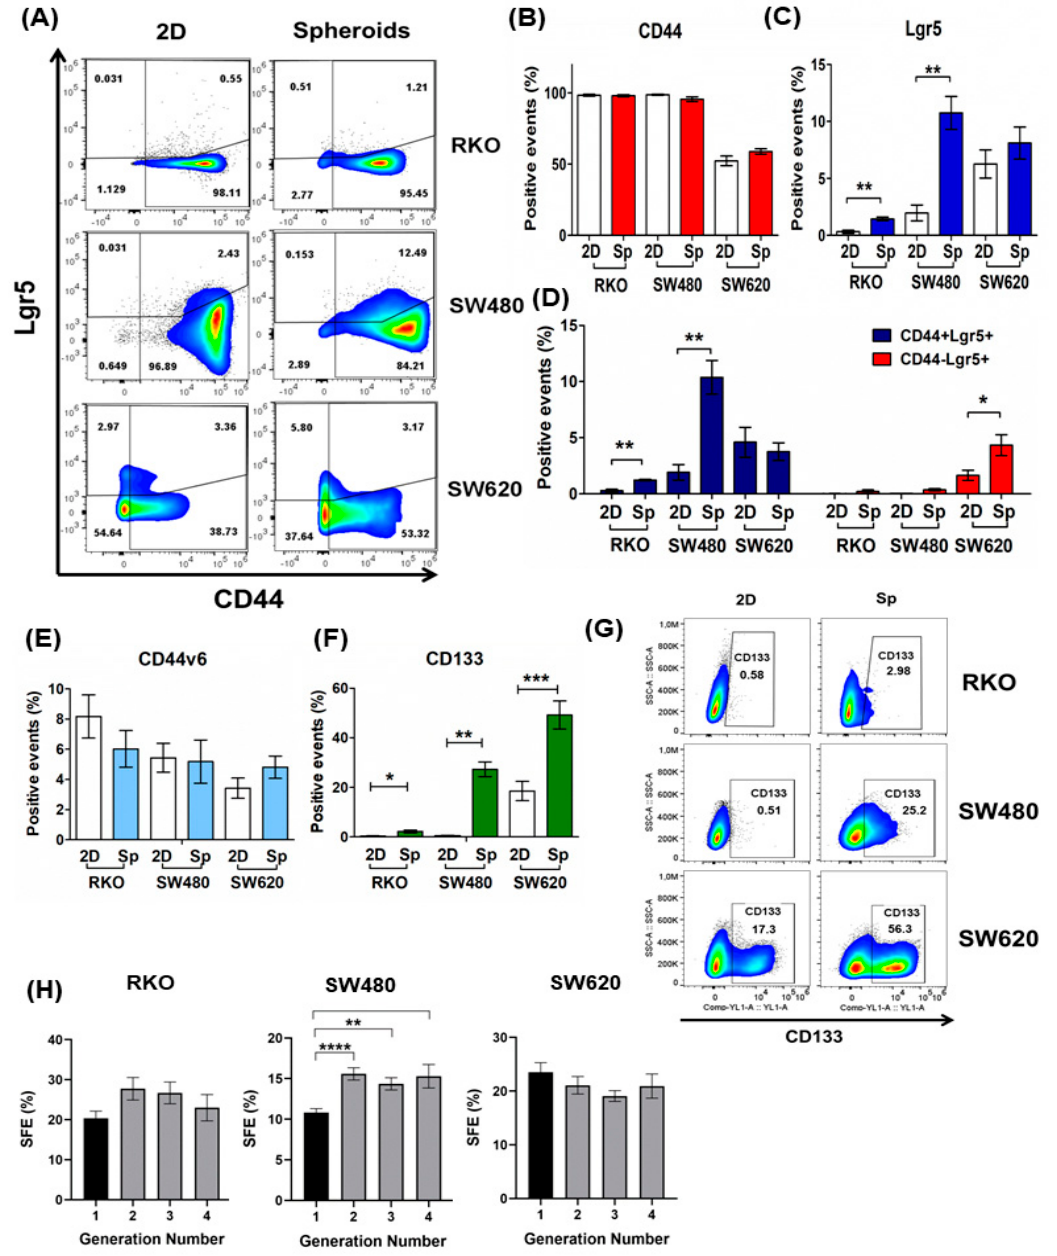
Figure 1. Spheroids as a model of cancer stem cells (CSCs) enrichment of CRC cell lines. ( A – G ) Com- parative expression of surface markers associated with stemness in second-generation spheroids compared to monolayer cultures (2D) in RKO, SW480, and SW620 cell lines. The proportions of CD44 ( B ), Lgr5 ( C ), CD44v6 ( E ), CD133 ( F , G ), CD44+Lgr5+, and CD44 − Lgr5+ subpopulations ( A , D ) were measured by flow cytometry. ( H ) Quantification of the spheroid formation efficiency (SFE %) of the RKO, SW480, and SW620 cell lines throughout four consecutive generations. Data are represented as the mean values ± SEM of at least three independent experiments. ( B – F ) Student’s t -test; ( G ) One-way ANOVA followed by Bonferroni’s multiple comparisons. * p < 0.05; ** p < 0.001; *** p < 0.0001; **** p <